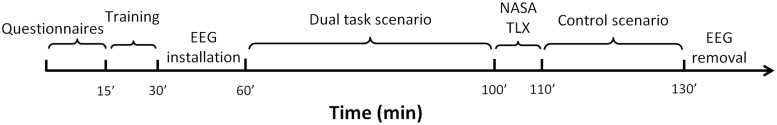
The procedure timeline.